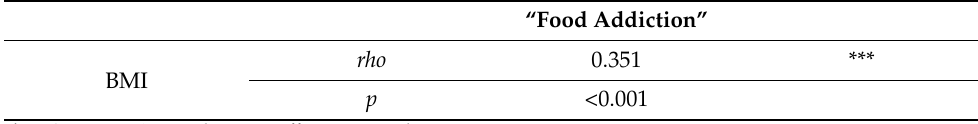
Table 4. Correlation between BMI and FA in the study